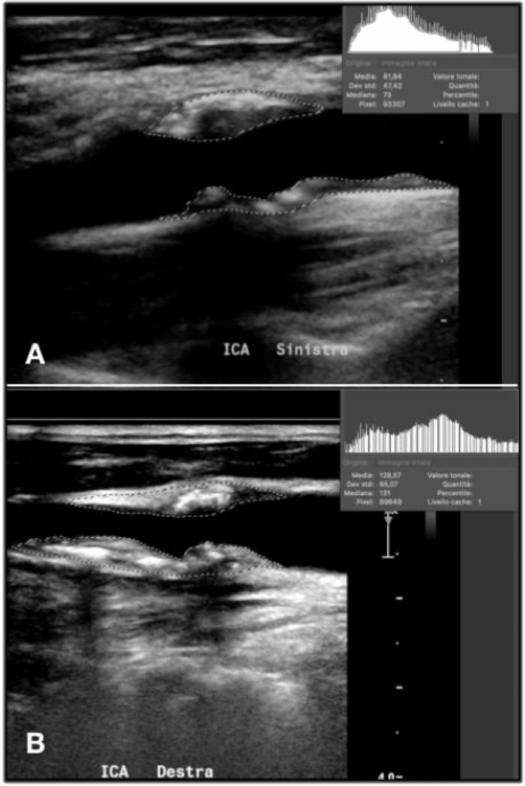
Figure 6. The GSM calculation in the case of an heterogenous composition ( A ) and an irregular profile ( B